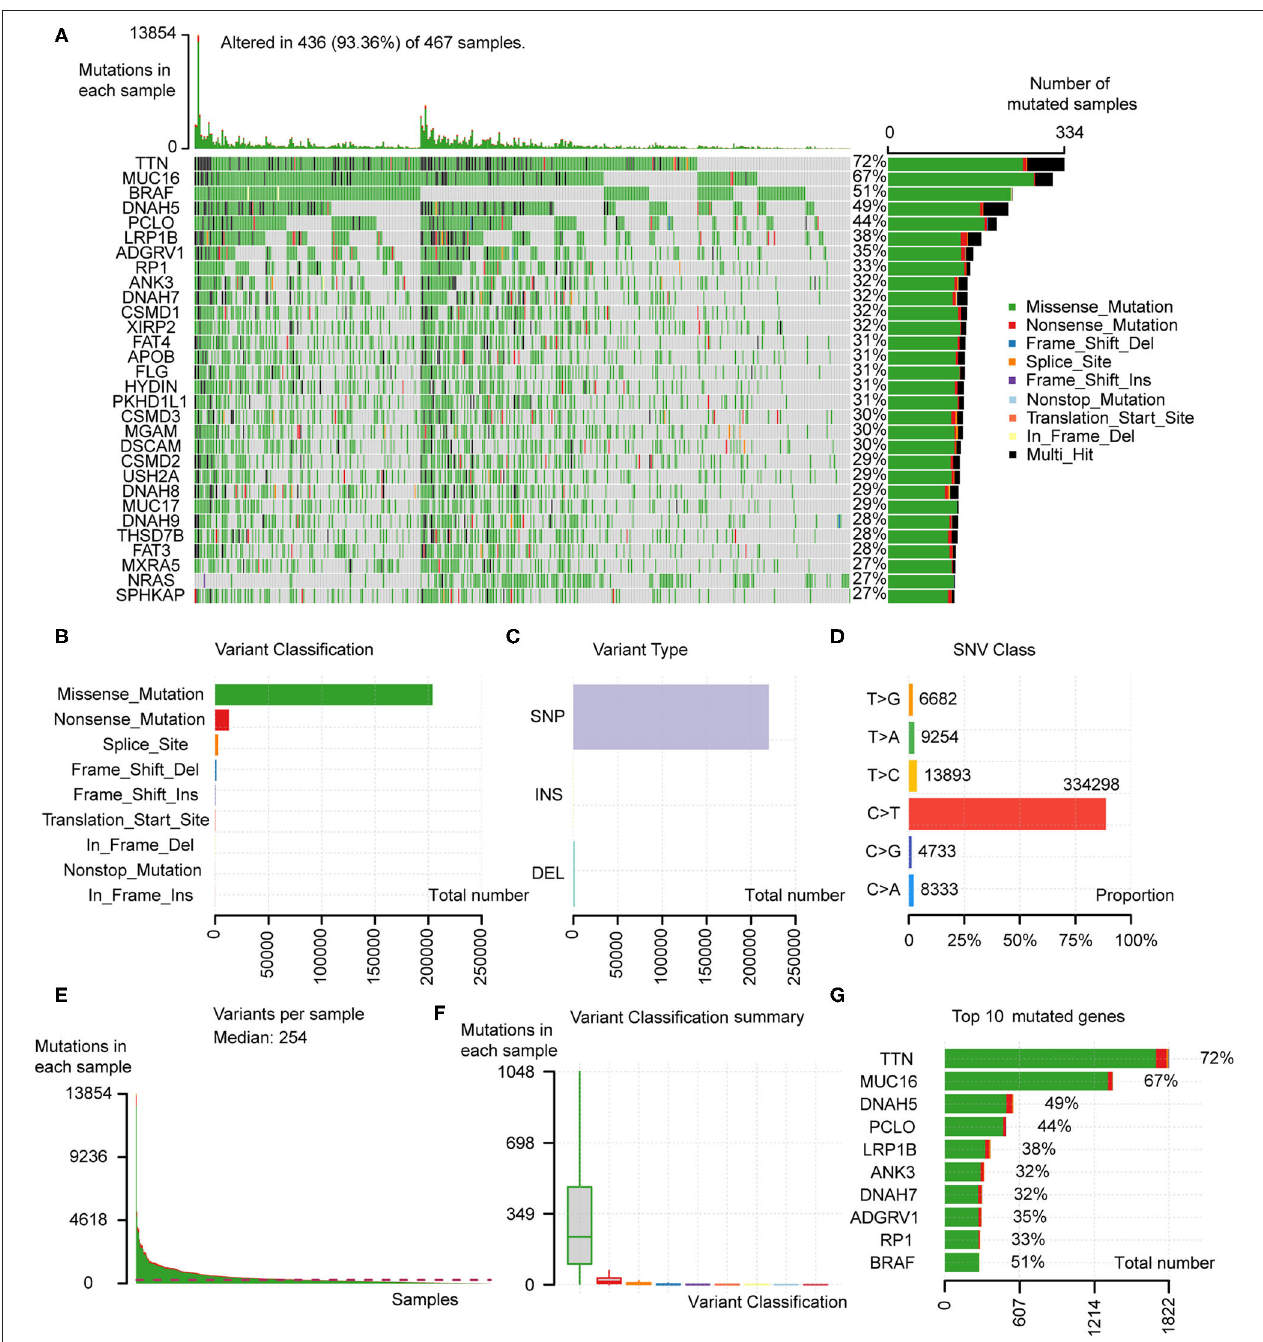
FIGURE 1 | Analyses of somatic mutation profiles in melanoma samples. (A) Waterfall plot of detailed mutation information of top 30 genes in each sample, with various color annotations to distinguish different mutation types. (B–D) According to different classification categories, missense mutation, SNP, and C > T mutation accounted for the overwhelming majority. (E) The total mutation number in each sample. (F) Box plots of each variant classification in each sample. (G) Top 10 mutated genes in melanoma. SNP, single nucleotide polymorphism; SNV, single nucleotide variants.